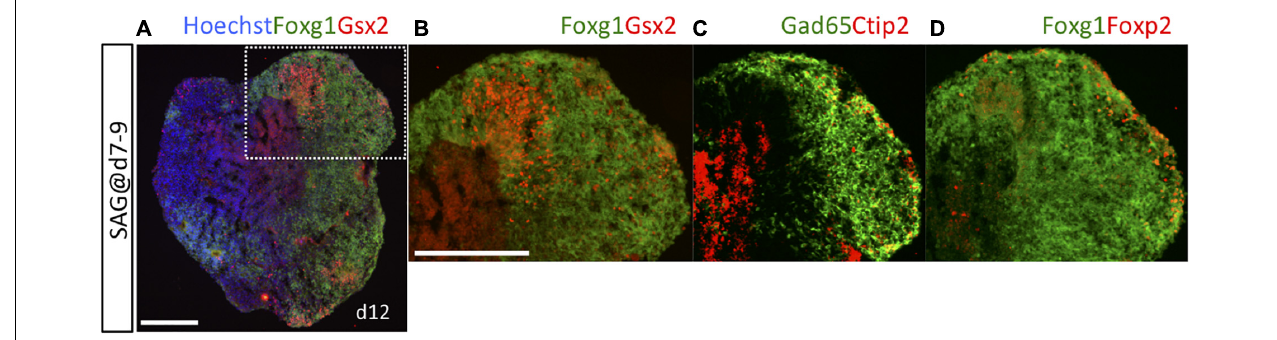
FIGURE 3 | Post-mitotic LGE neurons were detected on day 12. Cell aggregates were cultured with 3-nM SAG during days 7–9 and analyzed on day 12. (A) Fluorescence image of an entirely Foxg1::venus + aggregate (green) immunostained for Gsx2 (red) to show the induction of LGE progenitors. Hoechst 33342 (blue), nuclear staining. White dotted rectangular area is magnified in (B–D) . (B) Gsx2 + /Foxg1 + LGE progenitors are located at the inner side within an area of Foxg1 + cells. (C) Expression of the pan-GE post-mitotic neuron markers Gad65 and Ctip2. (D) Expression of the LGE-specific post-mitotic neuron marker Foxp2. Foxp2 + neurons and Ctip2 + neurons are localized in the marginal areas of Gad65 + and Foxg1 + zones. Scale bars, 200 µ